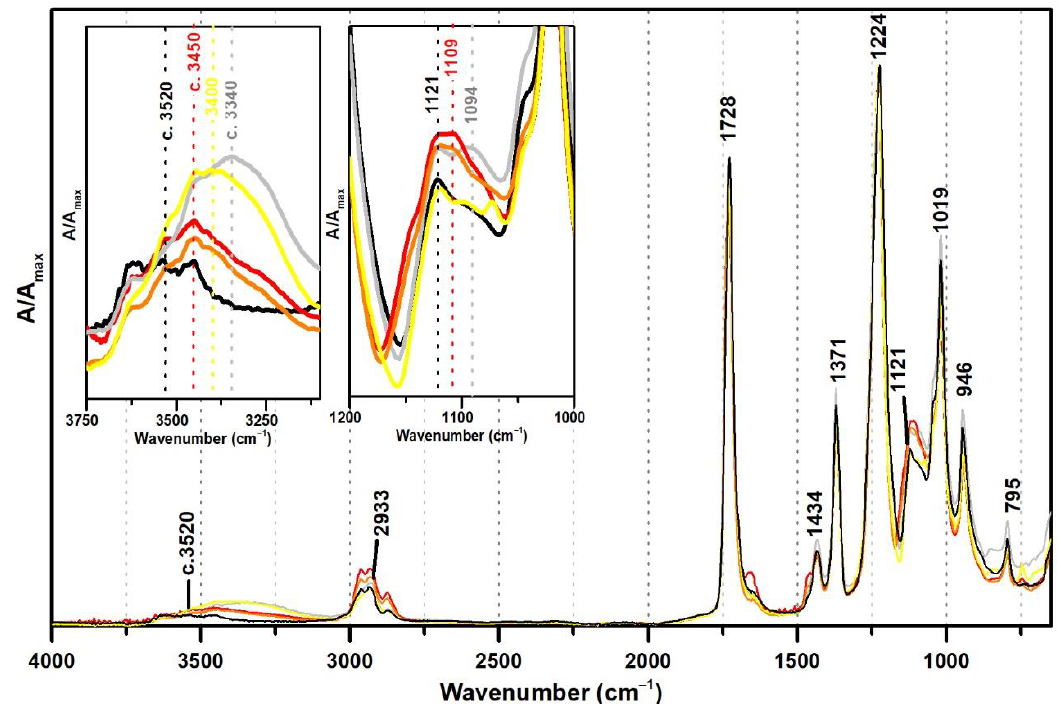
Figure 3. Infrared spectra in ATR of the pure PVAc emulsion (black), PVAc stabilised with 10% PVAl (grey), Polidisp DM21 (red), Polidisp DM23 (orange), and Imofan AV44/11 (yellow). Insets: details between 3750–3100 cm −1 and between 1200 and 1000 cm −1 . According to technical data sheets, Polidisp DM21 and DM23 are composed of P(VAc-VeoVa), and according to [5], Imofan AV44/11 is composed of P(VAc-VeoVa) plasticised with DiBP.